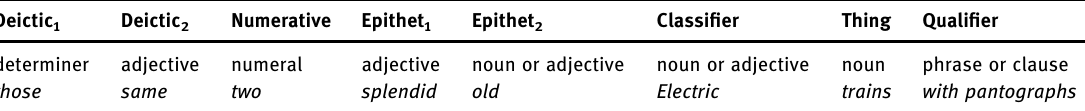
Table 2: Halliday ’ s experiential structure of the nominal group ( 1985, 159 )